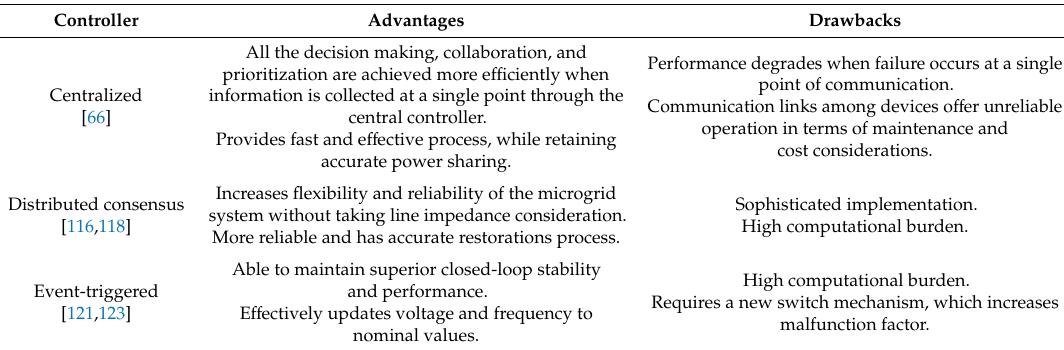
Table 3. Performance comparison of voltage and frequency of secondary